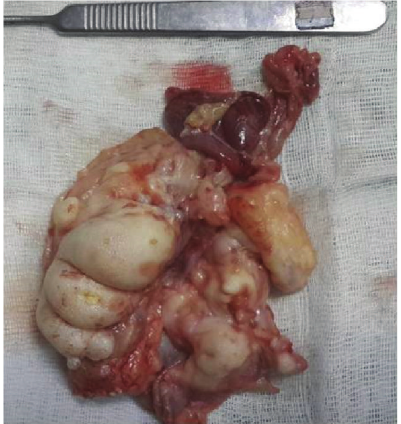
Figure 3: Macroscopic appearance of the excised teratoma.